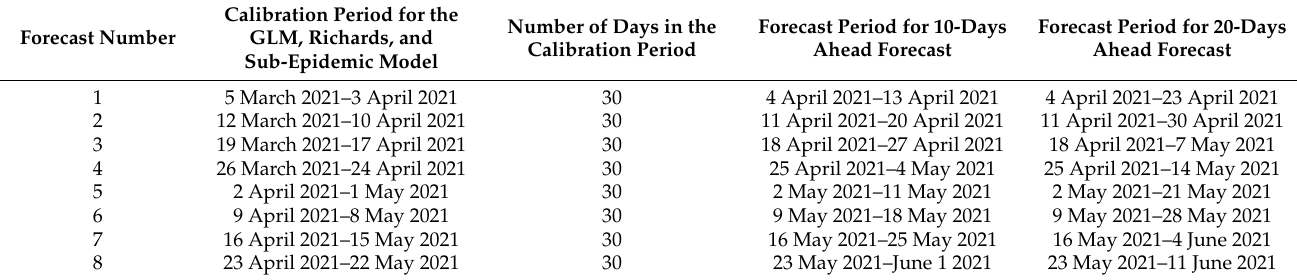
Table 1. Calibration period and forecast period for each